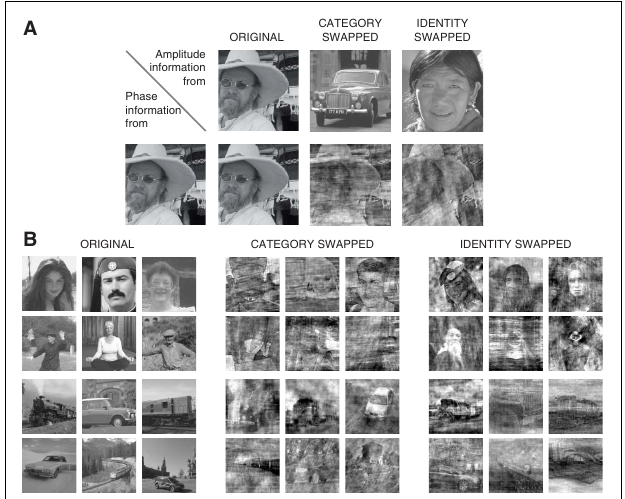
FIGURE 5 | Images used in Experiment 2. (A) Principles of the different possible combinations between amplitude and phase spectrums with examples for an image. (B) Examples of images used in the three conditions, faces on top and vehicles on